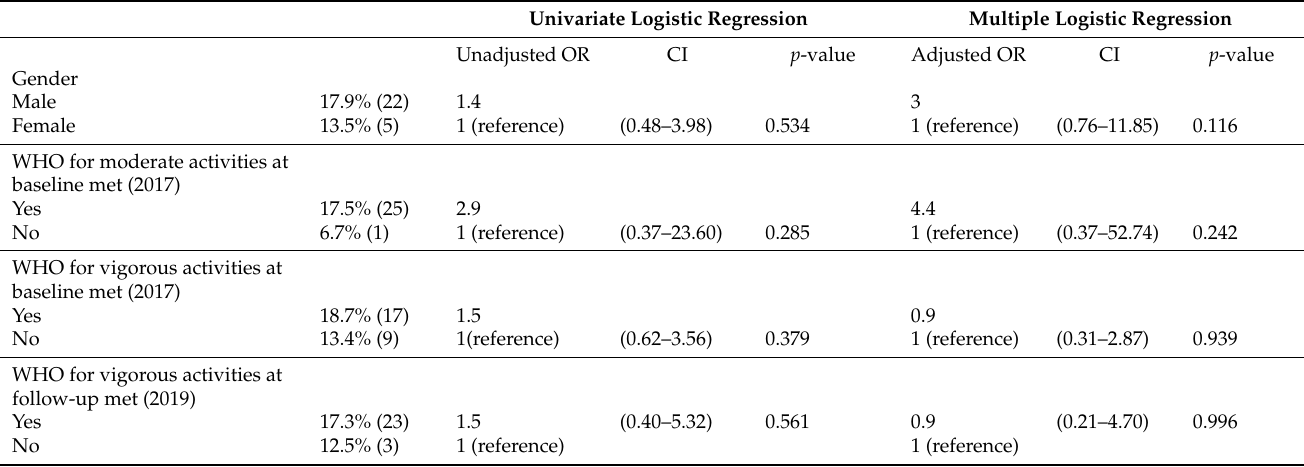
Table 7. Logistic regression analysis for factors associated with MetS development at 24-months post-migration ( n = 160) ¥